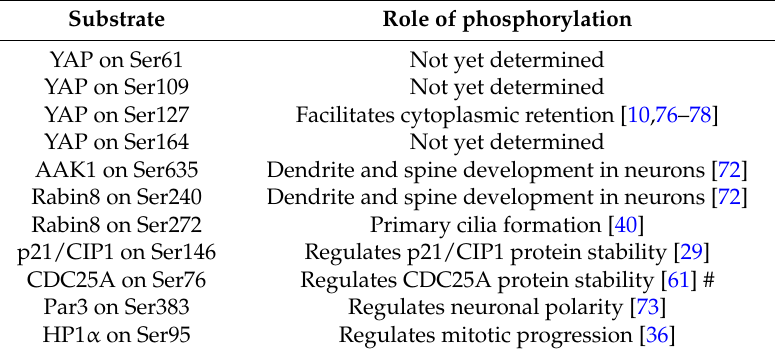
Table 2. Summary of direct downstream events/substrates of NDR1/2